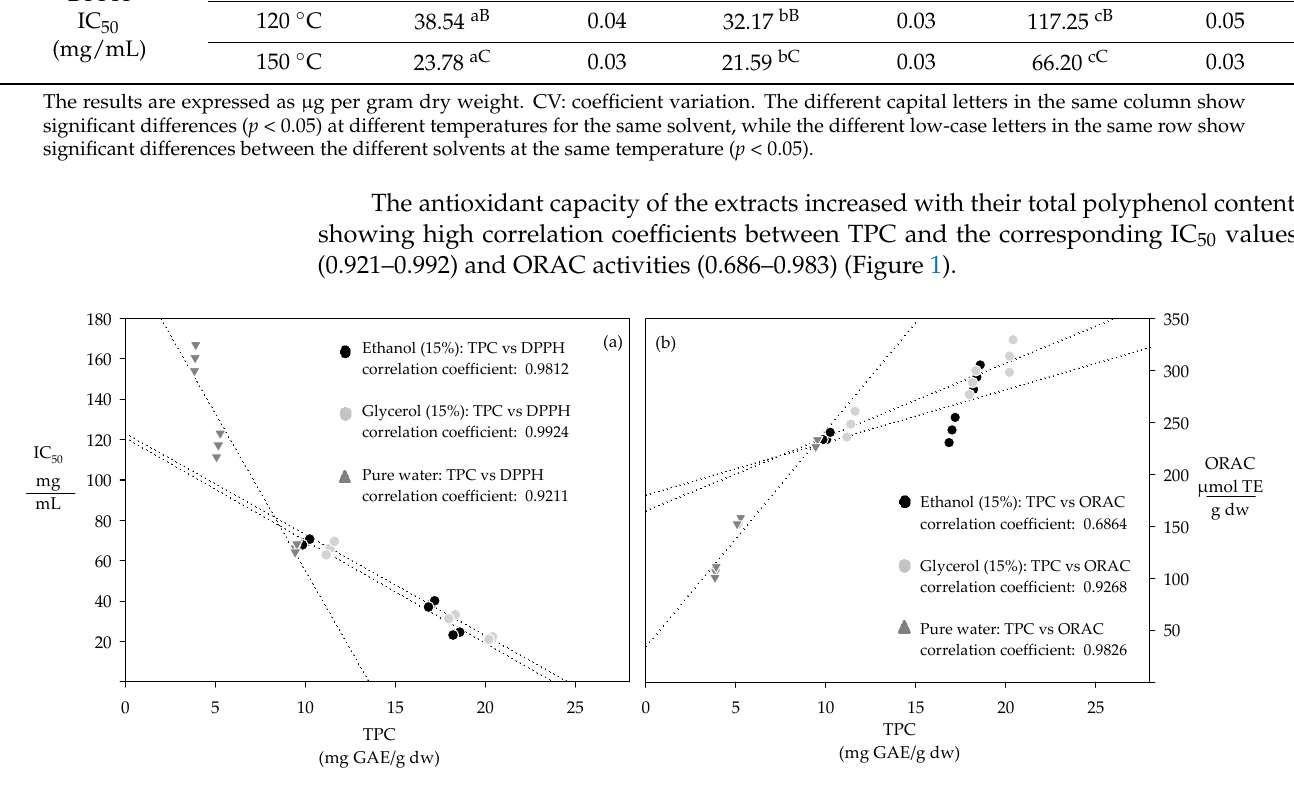
Figure 1. Correlation between the total polyphenol content and the antioxidant capacity represented by, ( a ) IC 50 and ( b ) ORAC.